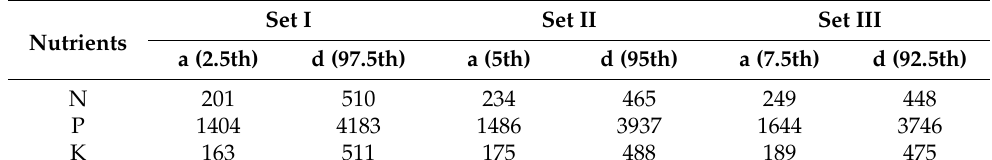
Table 5. Constants a and d were calculated by excluding the upper and lower 2.5th (Set I), 5.0th (Set II) and 7.5th (Set III) percentiles of all nutrient efficiency data of the combined dataset. Nutrients